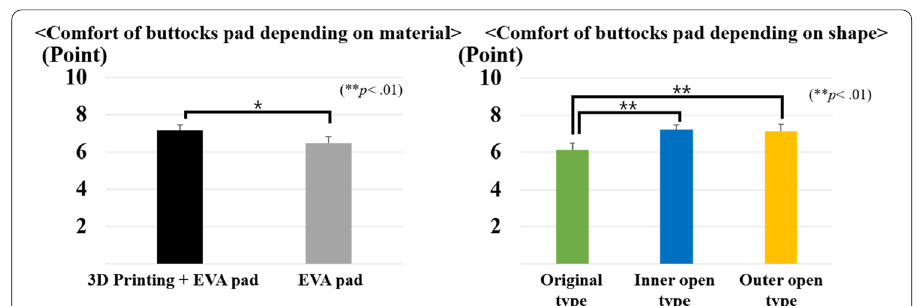
Fig. 8 Wearing comfort of buttocks pad depending on material and shape (Bonferroni post hoc analysis